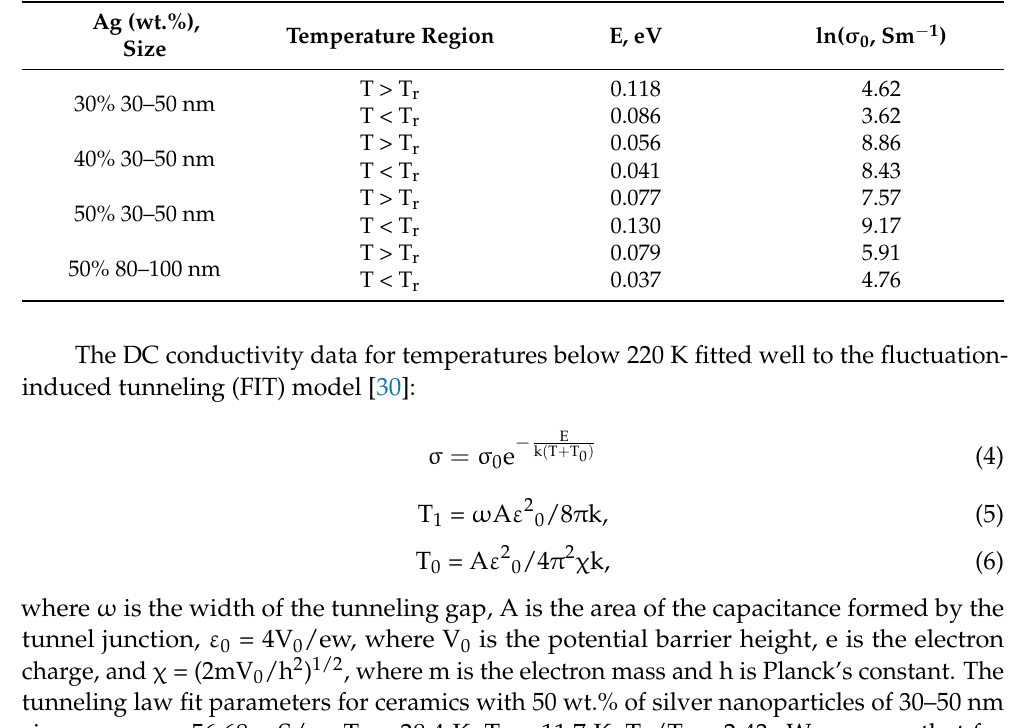
Table 2. Fit parameters of the temperature dependence of DC conductivity in different temperatures